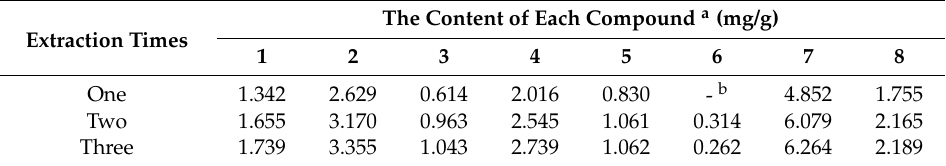
Table 2. The investigation of different extraction